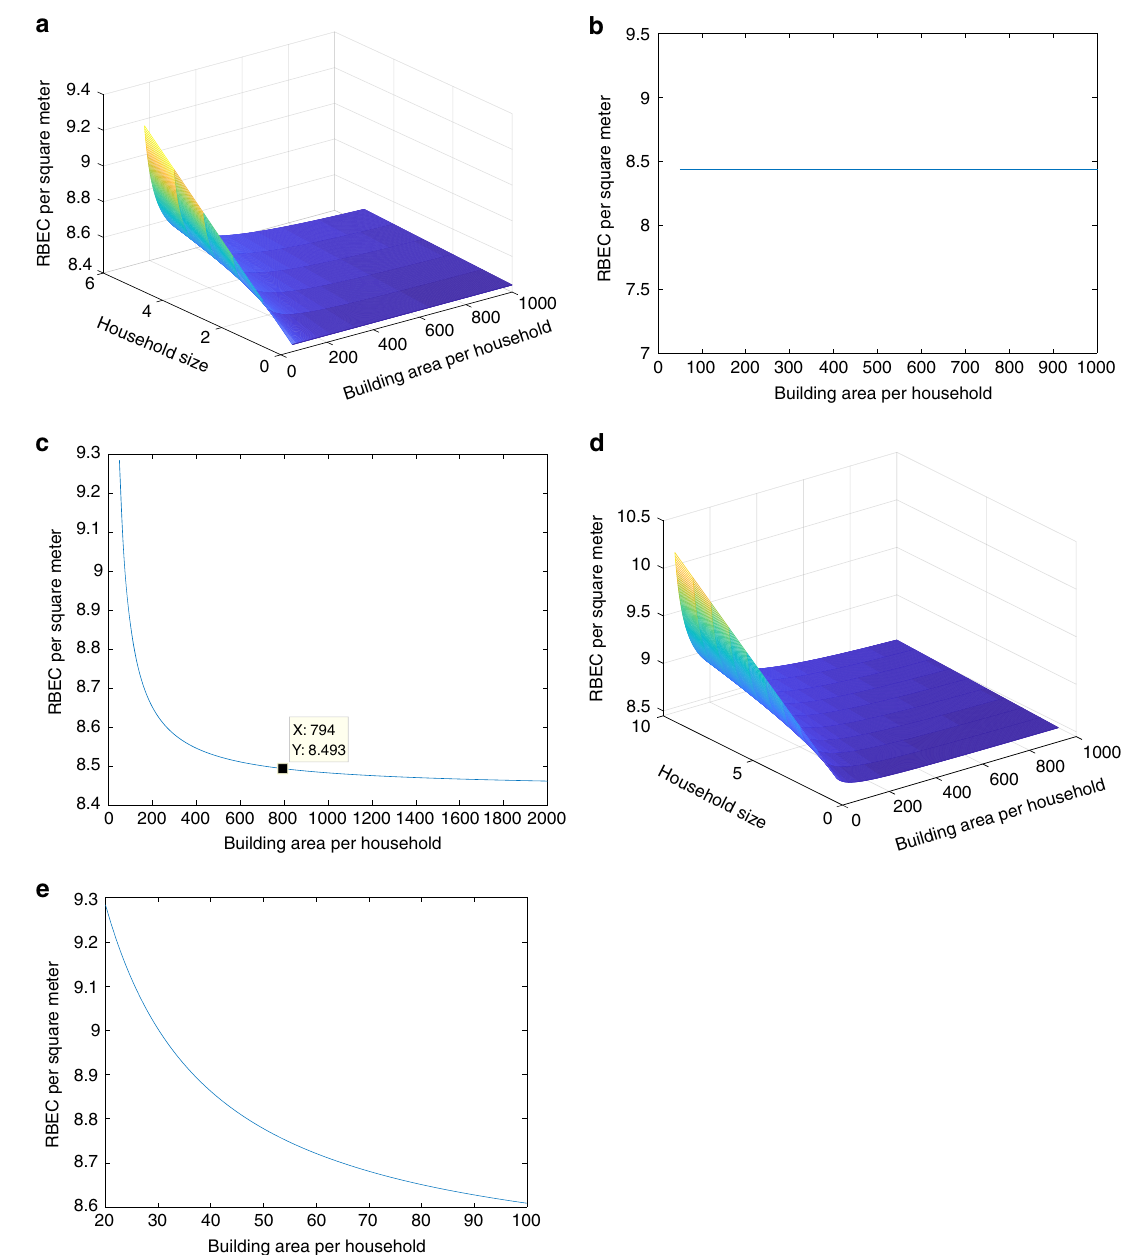
Fig. 5 The in fl uence of different phenomena on the dilution effect. a In fl uence of the multi-house family (for avoiding summer heat or winter cold). The residence time for these houses is shortened greatly. According to Eq. (4), this will lead to an ampli fi cation (for large houses) or weakening (for small houses) effect on the dilution effect. b In fl uence of the multi-house family (for investment). Many houses will be left vacant, for which e 1 = 0 and e 2 is a constant. This leads to a similar in fl uence on the dilution effect as the fi rst scenario, but the ampli fi cation and weakening effects are more pronounced. c In fl uence of the family tenant. In this case, a family lives normally in the house and the dilution effect is not in fl uenced. d In fl uence of the multi-person tenant. In this case, hypotheses (a) and (b) above are invalid. This leads to a weakening (for large houses) or ampli fi cation (for small houses) effect on